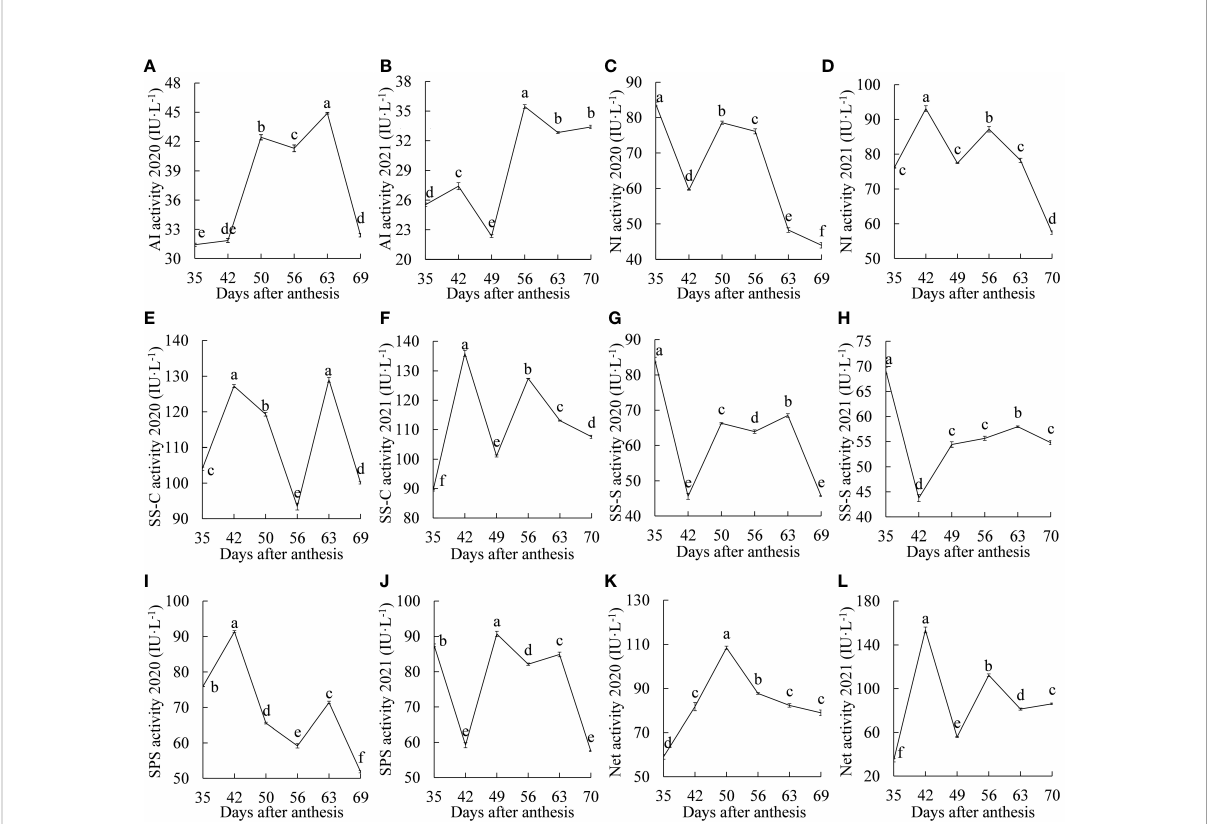
FIGURE 2 Dynamic changes in sucrose metabolism enzyme activities between 2020 and 2021. (A, B) acid invertase; (C, D) neutral invertase; (E, F) sucrose synthase-cleavage; (G, H) sucrose synthase-synthesis; (I, J) sucrose phosphate synthase; (K, L) the net activity of sucrose metabolism enzymes. Different letters indicate signi fi cant differences during growth at P = 0.05. Error bars represent the standard error of the mean ( SEM